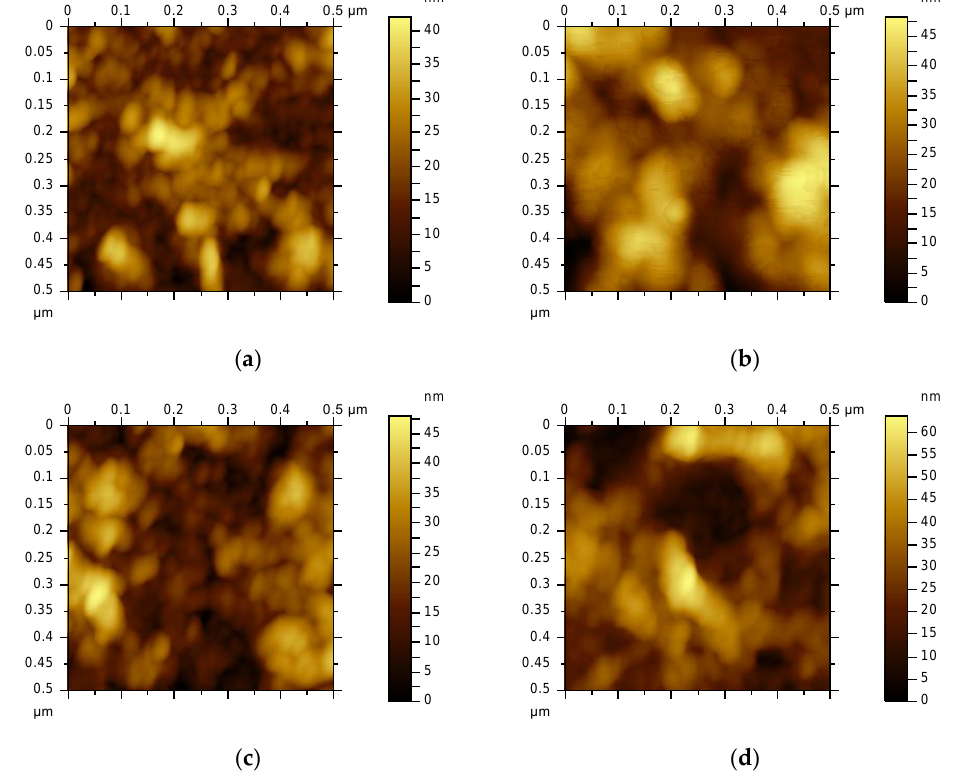
Figure 6. AFM images of (PAH/DY) 6 PAH films over a 500 nm × 500 nm scanned area ( a ) before thermal treatment and after thermal treatments at ( b ) 46.2 °C ( c ) at 3.3 °C, and ( d ) at −13.3 °C. All films display continuous film coverage free of defects.